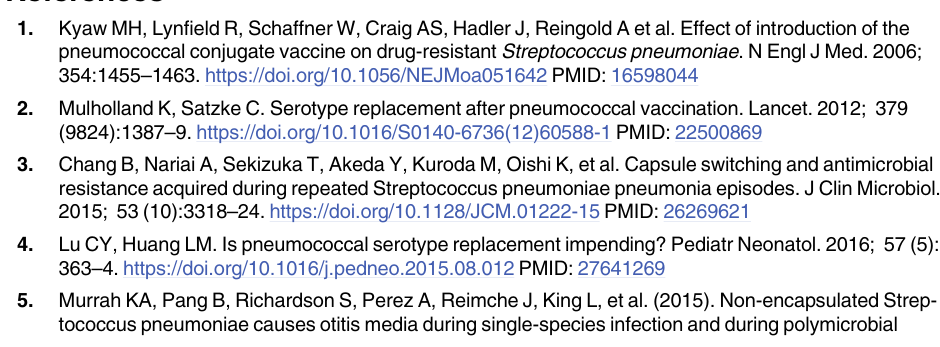
S1 Fig. Biofilm formation capacity of R6 and T2. S trains were grown in CpH8 to OD